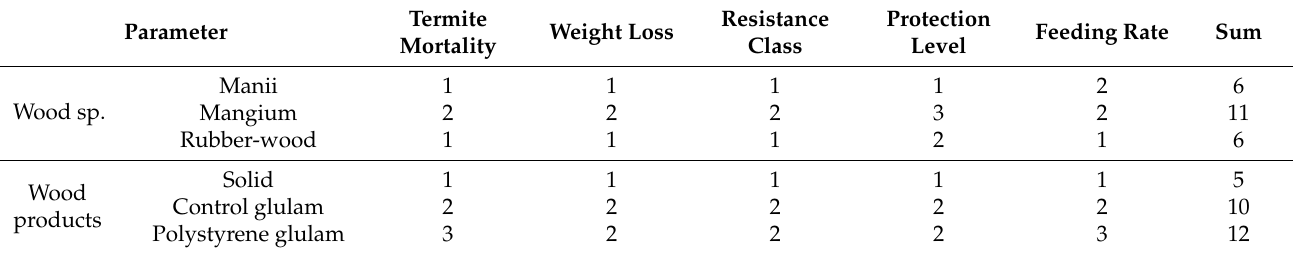
Table 7. Prioritizing wood species and wood